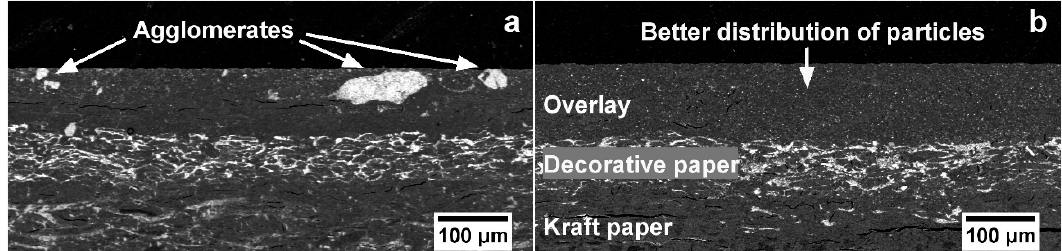
Figure 3. Cross-sectional SEM images of laminates with ( a ) 10 wt % of as-received alumina particles and ( b ) 10 wt % of functionalized alumina particles.